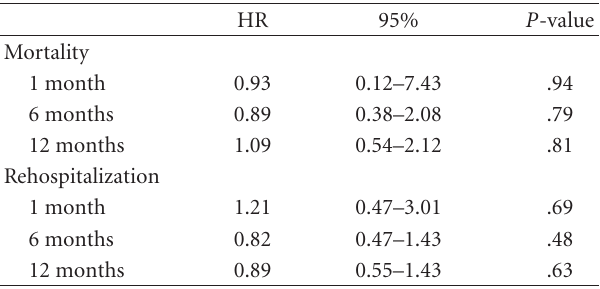
Table 4: Association of WRF (GFR) with mortality and rehospital- izations risks.